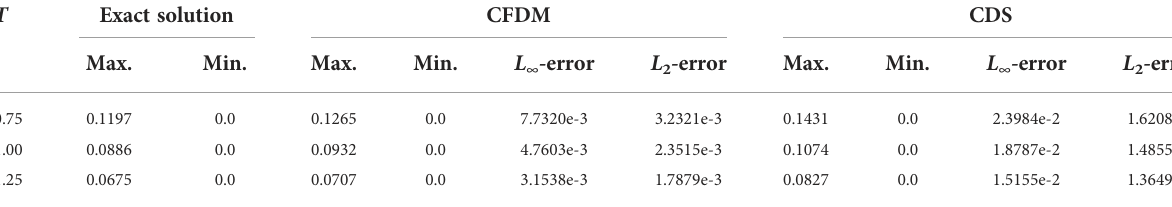
TABLE 3 The maximum and minimum values and errors of the 3D moving Gaussian